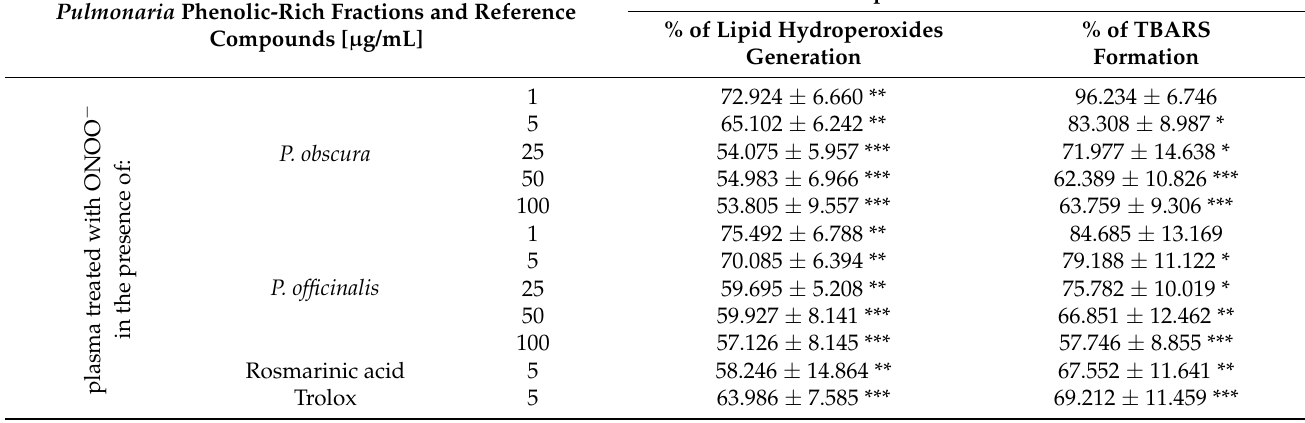
Table 5. Protective effect of Pulmonaria phenolic-rich fractions on the 100 µ M ONOO − -induced peroxidation of blood plasma lipids. The peroxidation of blood plasma lipids in samples treated with ONOO − in the absence of the examined substances was assumed as 100% of lipid peroxidation (* p < 0.05; ** p < 0.01; *** p < 0.001; n = 8). Pulmonaria Phenolic-Rich Fractions and Reference Compounds [ µ